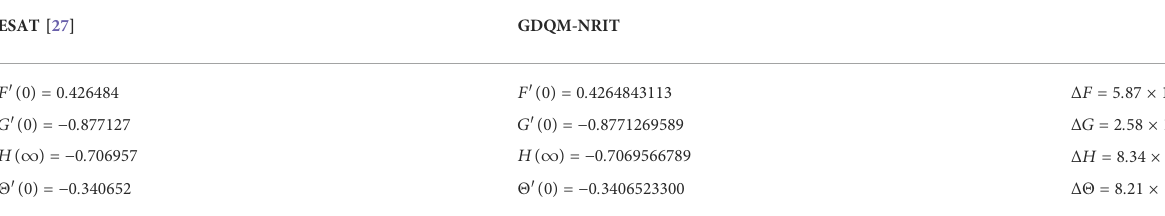
TABLE 2 Comparison between the results of GDQM-NRIT and